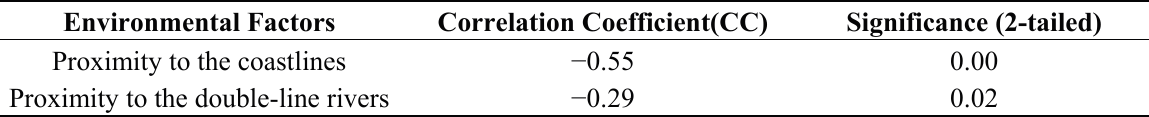
Figure10. The overlapped maps of hot spot clusters and double-line rivers of more than 400 m width. Table 4. Relationships between cholera and geographical environmental